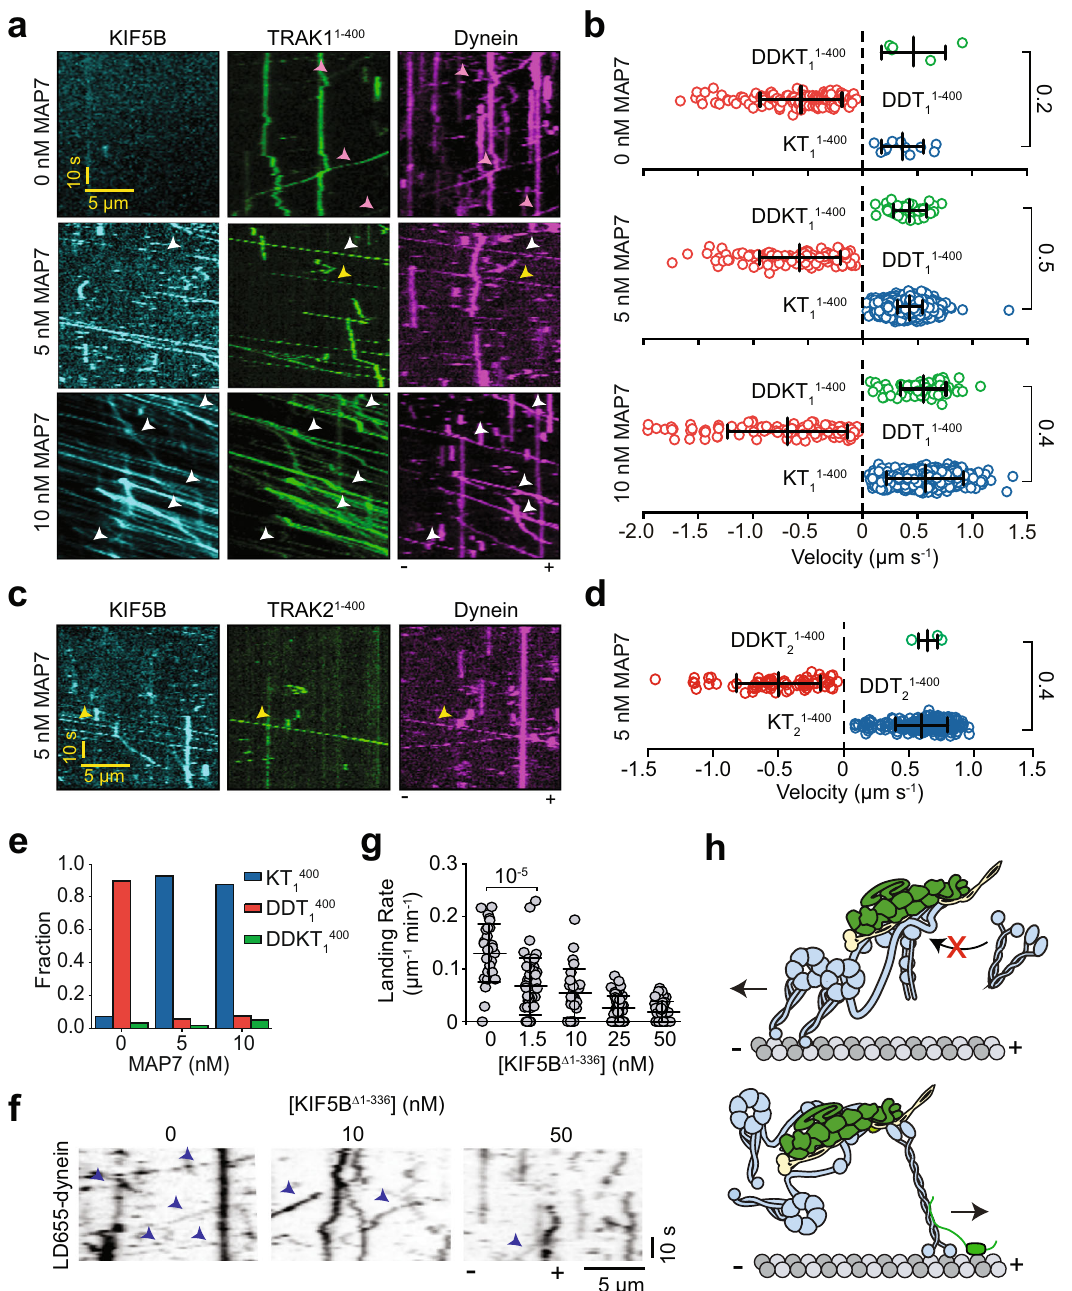
Fig. 4 | TRAK adaptors simultaneously recruit dynein-dynactin and kinesin. a Representative kymographs of Alexa488-kinesin, LD555-TRAK1 1 – 400 , and LD655- dynein in the presence of 0, 5, and 10nM MAP7. White arrowheads show coloca- lization of dynein, kinesin, and TRAK. Yellow arrowheads highlight the plus-end- directedmovementofdyneinandTRAKbyunlabeledkinesin.Magentaarrowheads represent the minus-end-directed movement of dynein and TRAK. b The velocity distribution of complex assemblies at 0, 5, and 10nM MAP7. Negative velocities correspondtominus-end-directedmotility.( n =5,138,11,43,130,2104,79,117,and 1342 from top to bottom, three independent experiments per condition). c Representative kymographs of Alexa488-kinesin, LD555-TRAK2 1 – 400 , and LD655- dynein on a surface-immobilized MT in the presence of 5nM MAP7. Assays were performedintheabsenceofLis1.Yellowarrowheadsshowcolocalizationofdynein, kinesin, and TRAK2. d The velocity distribution of complex assemblies at 5nM